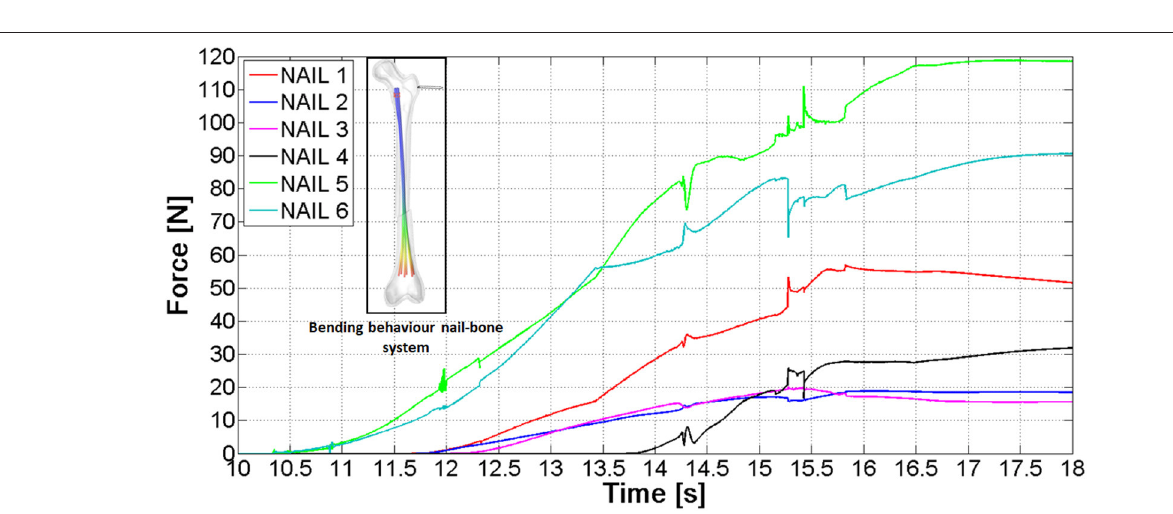
FIGURE 10 | Contact forces between the nails and the proximal bone